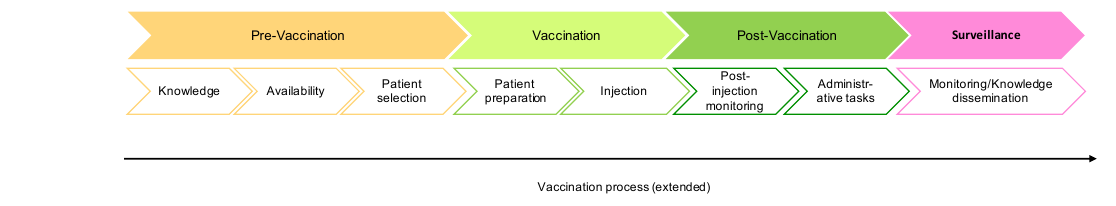
Figure 3. Phases of the extended vaccination